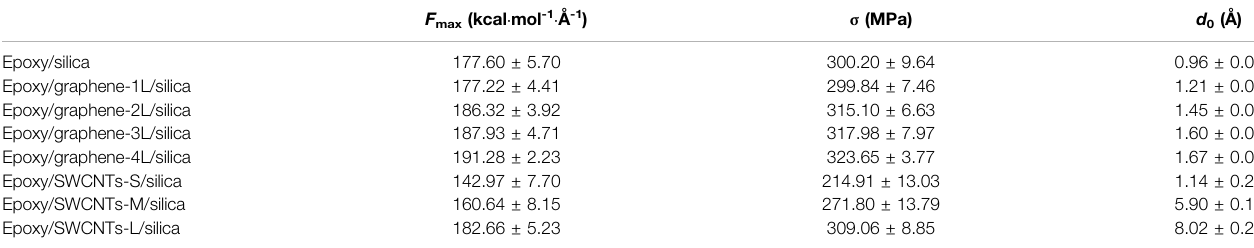
TABLE1| Interfacialpropertiesofdifferentstructures,includingthemaximumpullingforce( F max ),theadhesionstress( σ ),andthecorrespondingdisplacement d 0 atthepoint of F max .